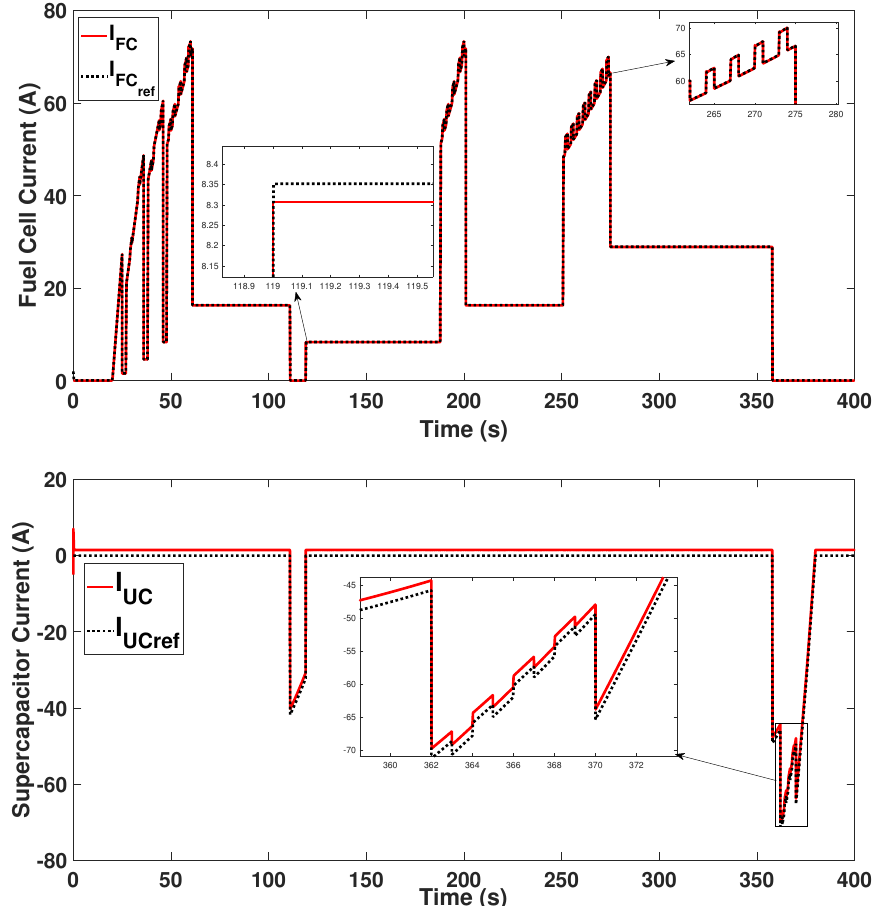
Figure 6. Current tracking using the Lyapunov-based adaptive controller.